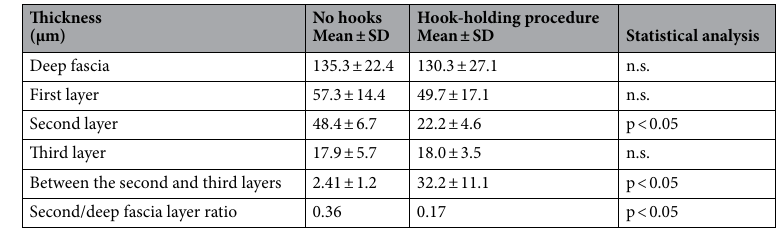
Table 1. Quantitative comparison of the thickness of the deep fascia, each layer, loose connective tissue between the second and third layers, and second layer/deep fascia thickness ratio with or without the hook- holding procedure. SD, standard deviation; n.s., not